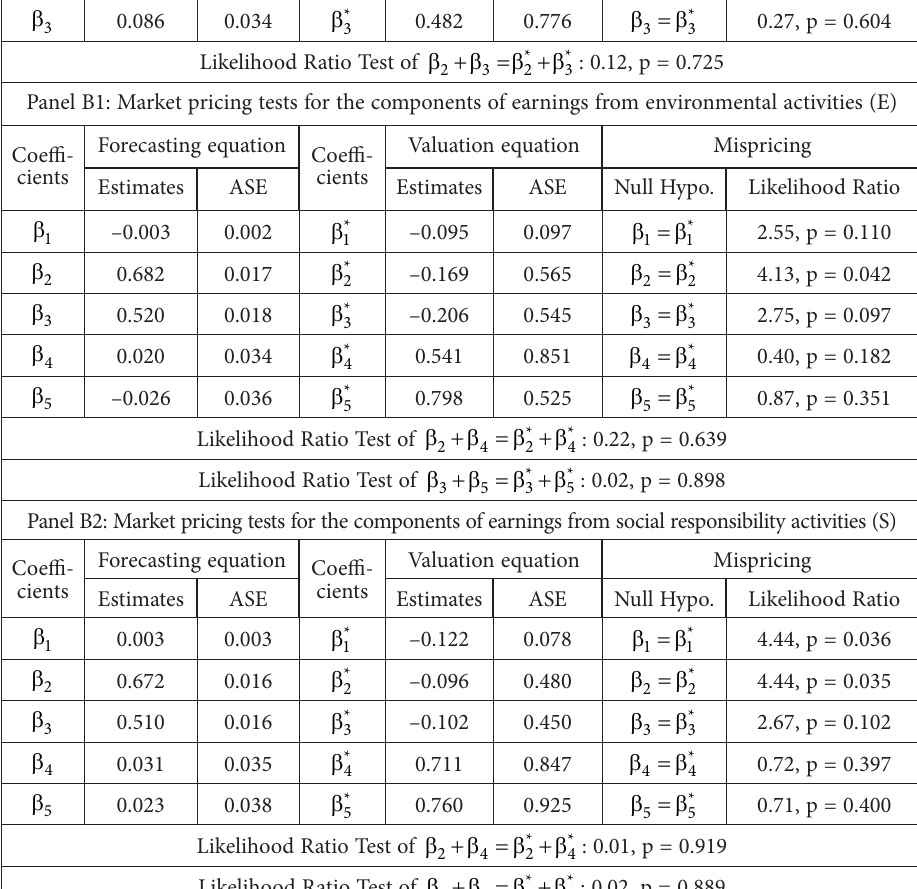
Panel A3: Market pricing tests for earnings from governance activities (G)